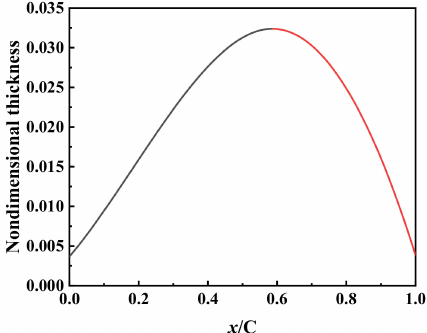
Figure 2. Schematic diagram of thickness